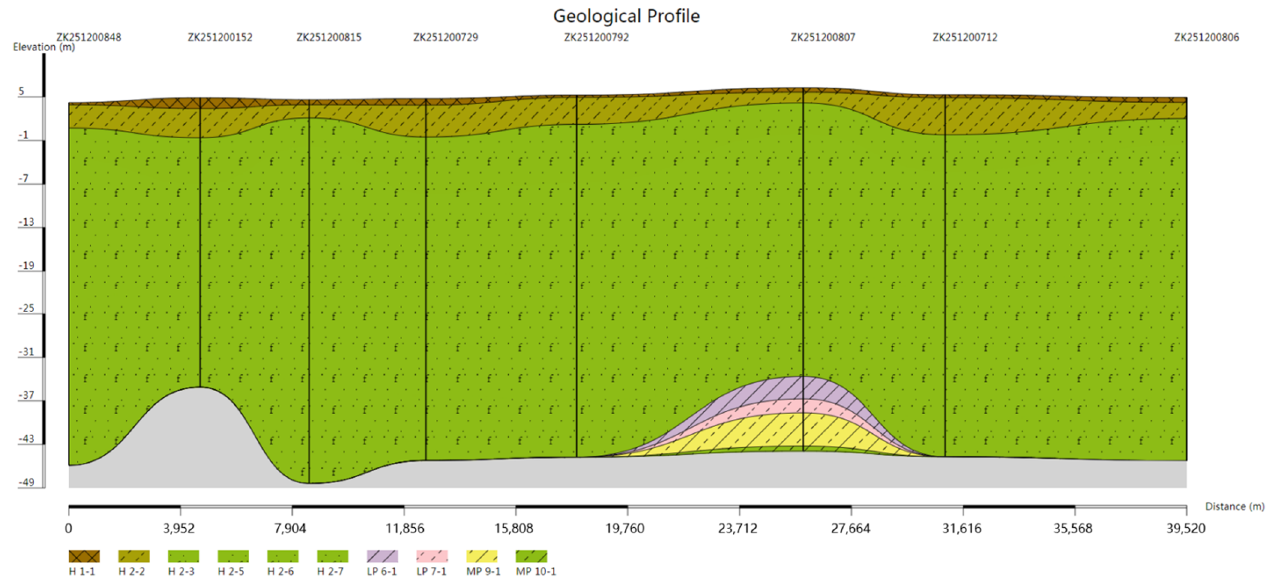
Figure 11. Geological profile V corresponding to drilling line V in Figure 7 by unique path method.